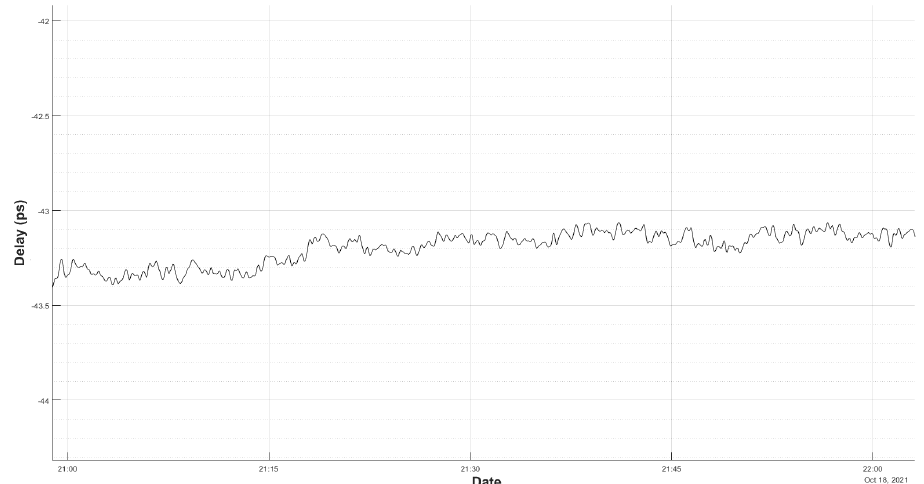
Figure 13. Zoom of 60 min of the delay measurement in a stable